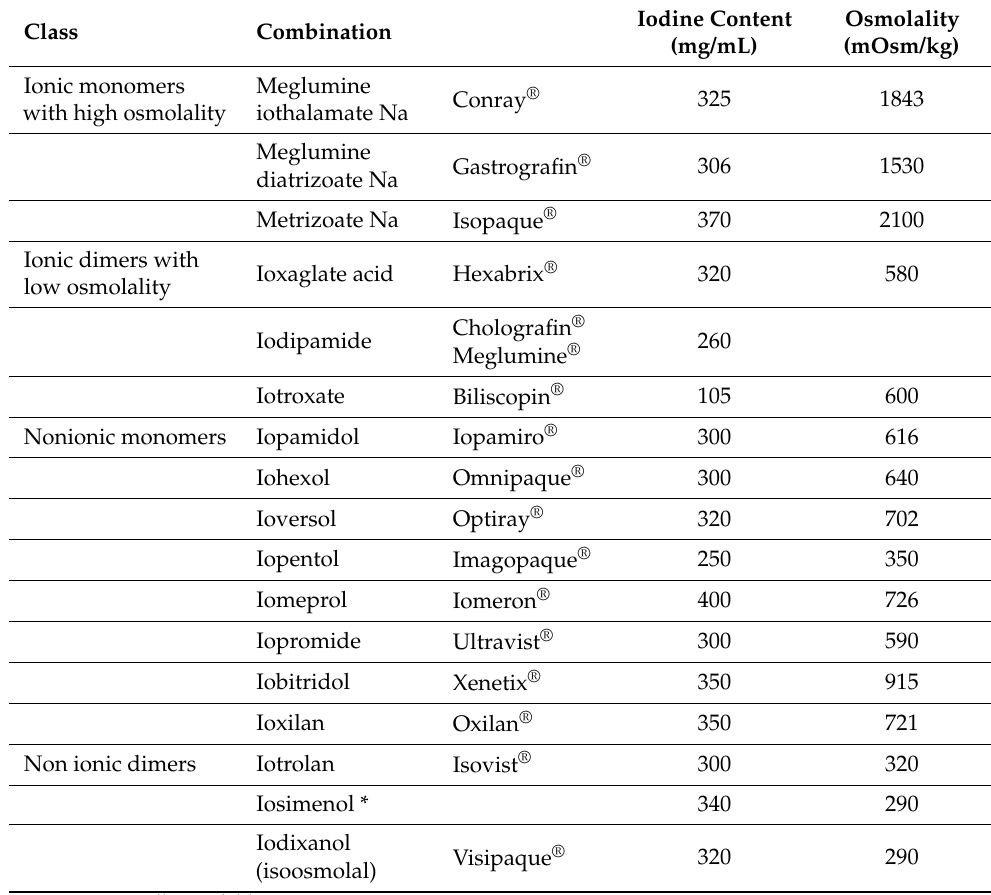
Table 1. Classification of water-soluble iodinated contrast